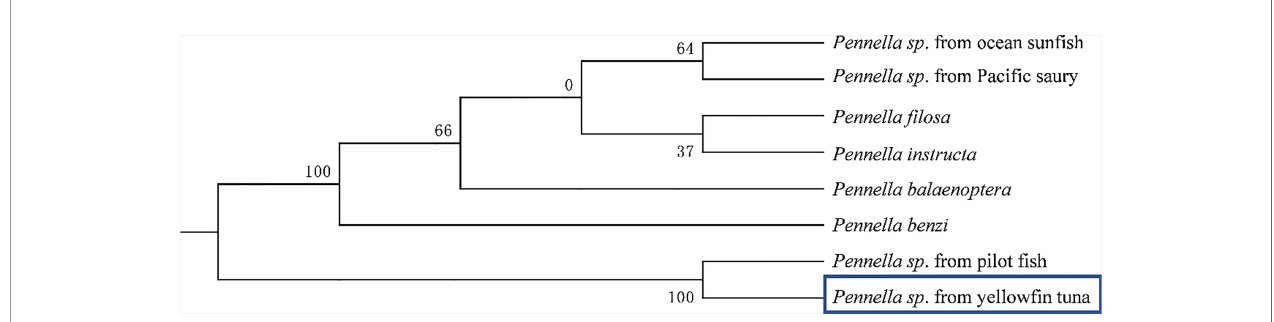
FIGURE 4 | The phylogenetic relationship was estimated using the Maximum Likelihood method for the COX1 genes. Genbank accession numbers: Pennella sp. from pilot fi sh (MZ934363), Pennella benzi (LC642589), Pennella sp. from Paci fi c saury (LC638600), Pennella sp. from ocean sun fi sh (LC638579), Pennella fi losa (LC642600), Pennella instructa (LC642628), Pennella